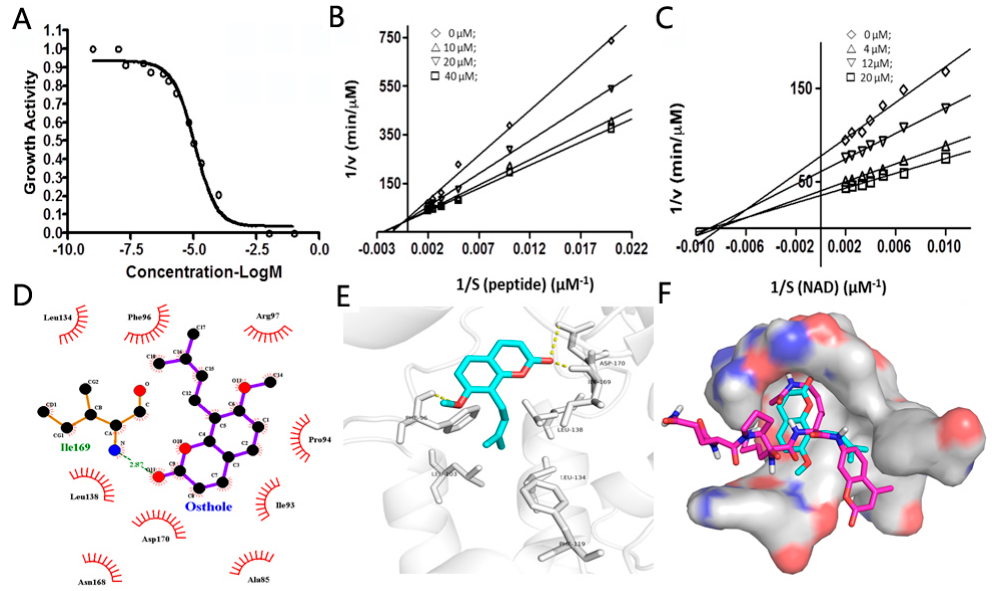
Figure 4. The inhibition mode study of osthole against SIRT2. ( A ) The measurement of IC 50 of osthole against SIRT2. Osthole was used from 0, 0.05, 0.1, 0.16, 0.5, 0.63, 1, 5, 10, 50, 100 μ M. ( B ) The